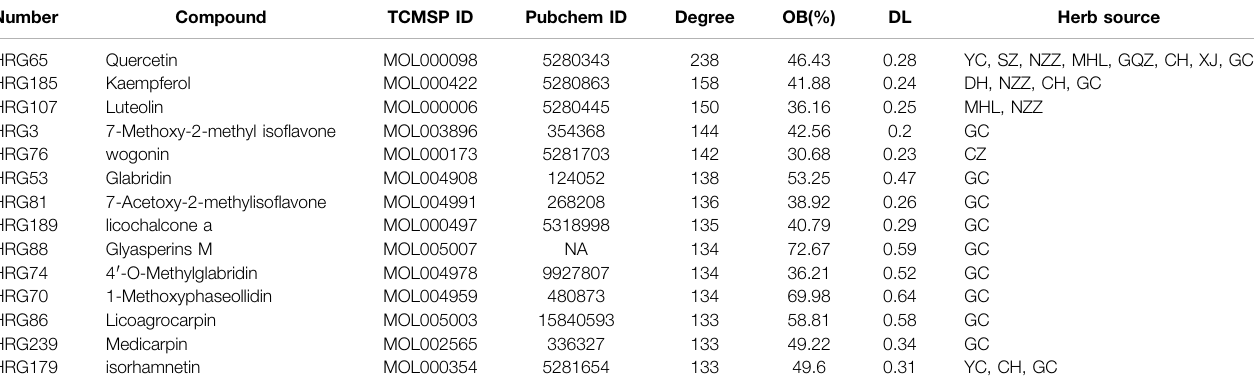
TABLE 3 | Compound information in the top 20 nodes in the “ herb-compound-target ” network of